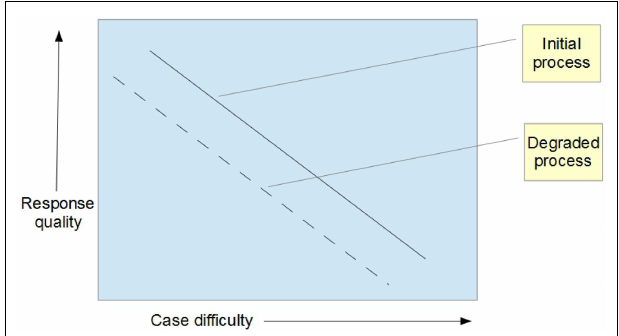
FIGURE 3 | Change in the process (degradation) from baseline .